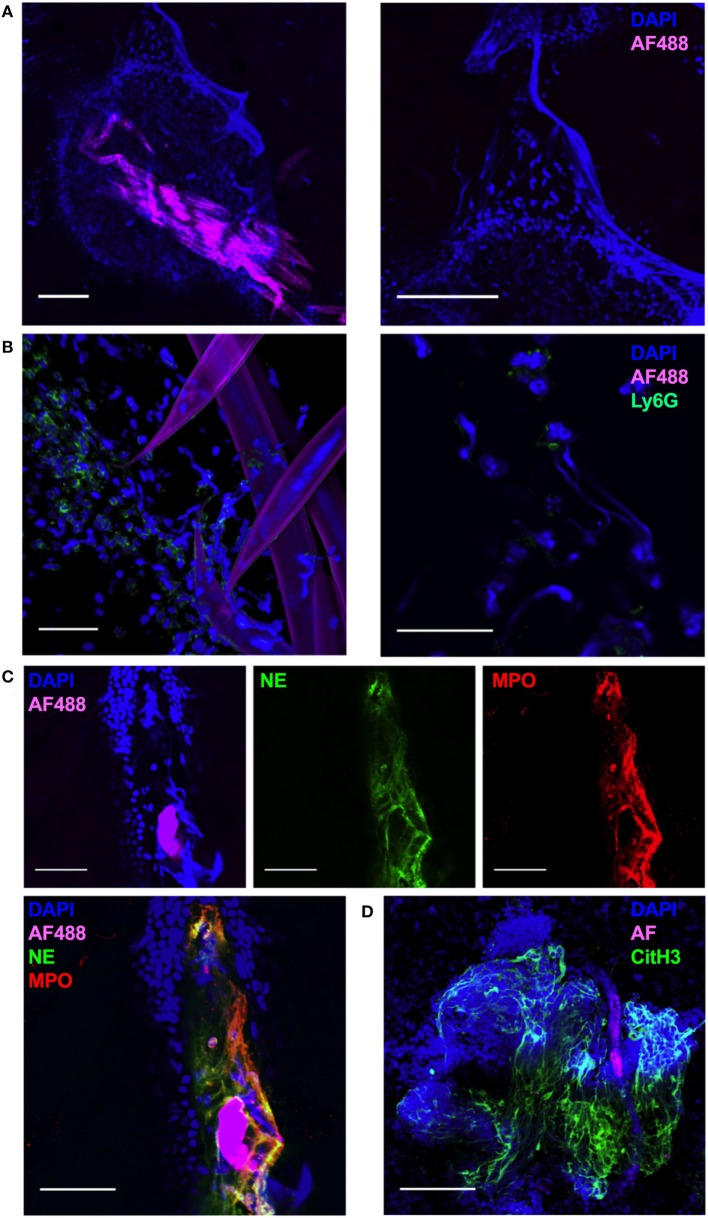
Nippostrongylus brasiliensis (Nb) induces the formation of neutrophil extracellular traps in skin. C57BL/6 mice were injected intradermally into the ear with 150 AF488+ Nb, and z-stacks of whole-mount ear dermis were analyzed by immunofluorescence and confocal microscopy at different time points. Images are representative of at least two independent experiments. (A) Dermis at 1 h after AF488+ Nb injection showing DAPI+ nuclei (blue) and AF488+ Nb (magenta). Bar = 200 µm. (B) Dermis at 2 h after AF488+ Nb injection showing DAPI+ nuclei (blue), AF488+ Nb (magenta), and Ly6G+ neutrophils (Green). Bar = 50 µm. (C) Dermis at 24 h after AF488+ Nb injection showing DAPI+ nuclei (blue), AF488+ Nb (magenta), myeloperoxidase (Red), and neutrophil elastase (Green). Bar = 50 µm. (D) Dermis at 48 h after AF488+ Nb injection showing DAPI+ nuclei (blue), autofluorescent Nb (magenta), histone H3 citrullination (Green), and neutrophil elastase (Red). Bar = 200 µm.